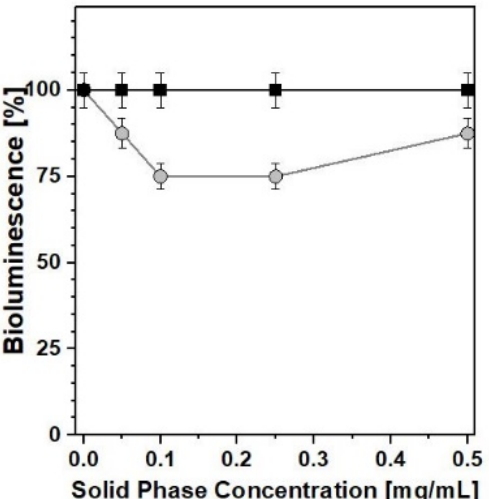
Figure 9. Chronic e ff ect of • PB_Syn and (cid:4) PB_Com samples on A. fischeri F1 bioluminescence. 24 h,